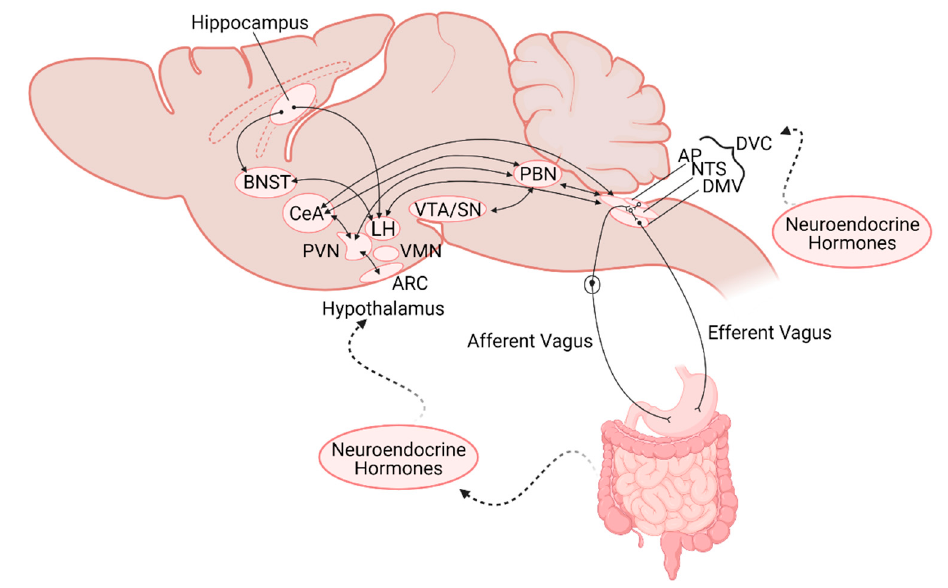
Figure 2. Schematic representation of the neuroanatomical connections between the gastrointestinal (GI) tract and central nervous system nuclei involved in regulation of GI functions and feeding.